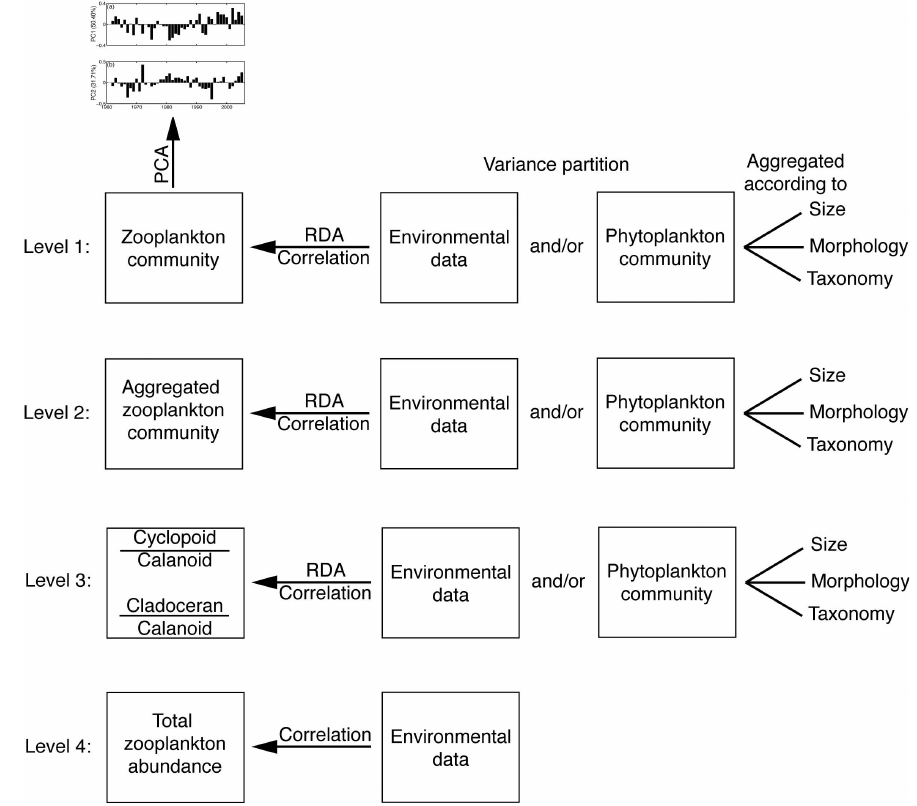
Fig. 4. Schematic illustration of the analytical procedure at various